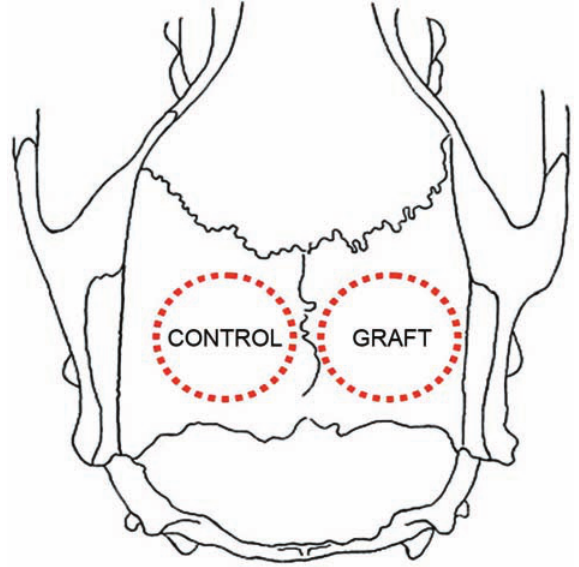
Figure 1- Rat calvaria scheme in an upper view. The 5-mm- diameter surgical bone defects were localized bilaterally at the parietal bones and were filled as